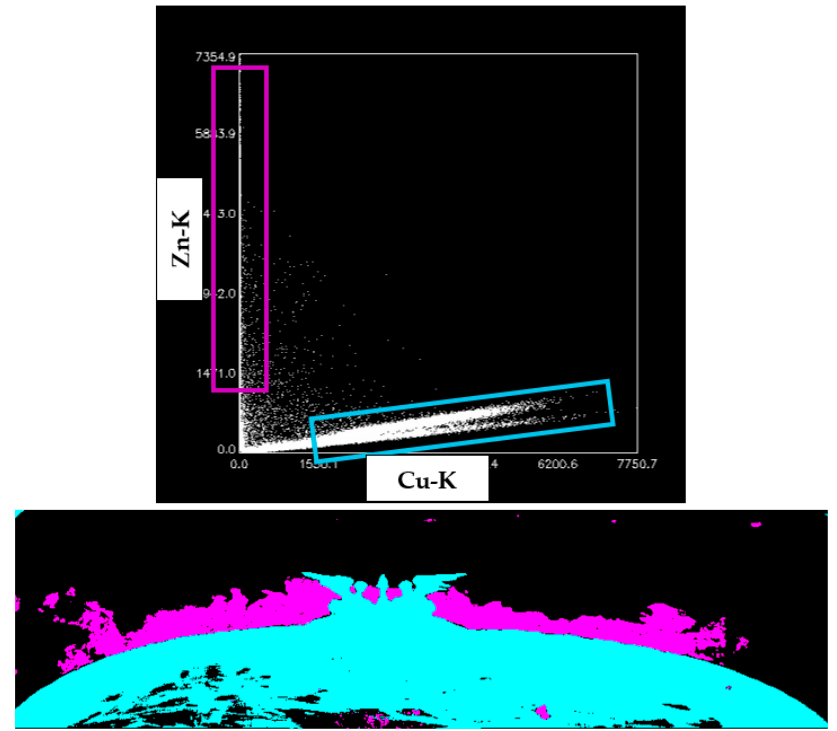
Figure 10. Scatter plot Cu-K vs. Zn-K of painting “ A poesia e o amor afastando a virtude do vício ” by Eliseu Visconti.